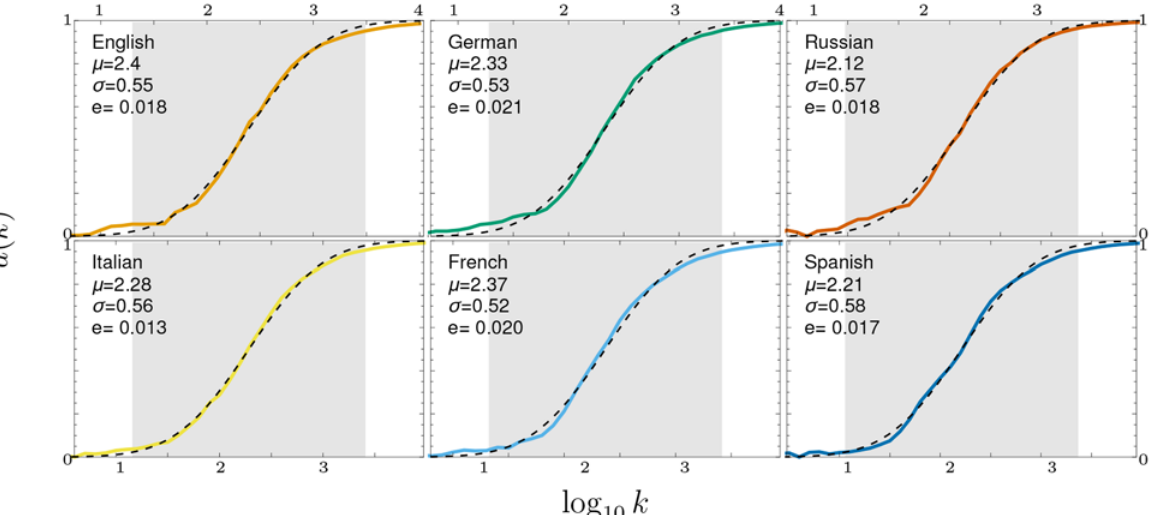
Fig 2. Rank diversity. Diversity d as a function of the rank k for different languages from 1800 to 2008, where d ( k ) measures how many different words appear for a given rank k during the time considered ( Δ t = 208). For example, for English, d (1) = 1/208, as the word ‘ the ’ appears in the first rank for all years considered. Although we have analyzed up to k (cid:1) 10 6 , rank diversity for k > 10 4 is not shown as d ( k ) (cid:1) 1, i.e. , a different word appears in each rank every year. Data are windowed over time, with a slot of size δ log 10 k = 0.1, for the sake of clearness. Additionally, the sigmoid defined in Equation 1 is shown as a black dashed curve, with the best fit parameters, also reported in each subfigure. The mean square error e between the data and the fit, is also given. The shaded region corresponds to the average “ body ” of all